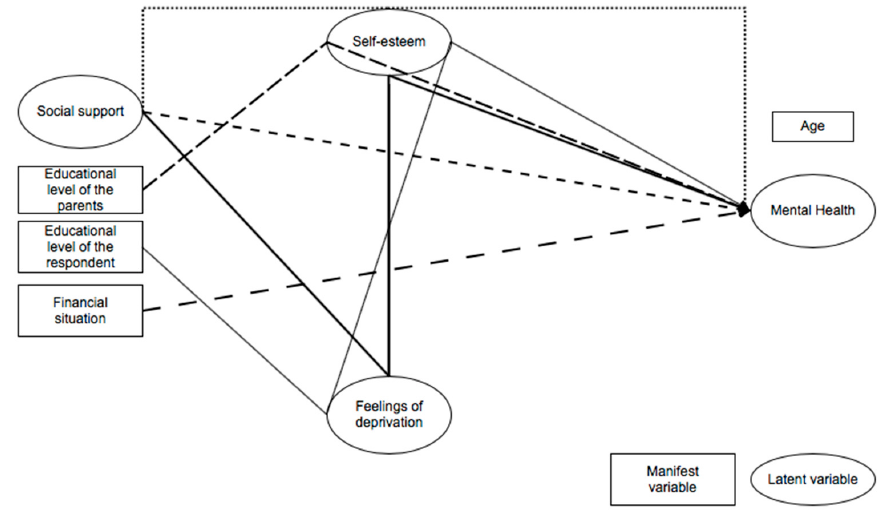
Figure 2. Visual representation of the different paths of the structural equation analysis—women. Note: Each path is represented with a different line. Estimates of the paths can be consulted in Table 4.